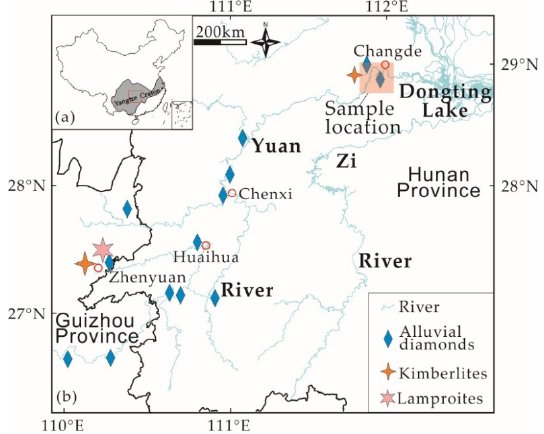
Figure 1. ( a ) Location map for the Yangtze Craton; ( b ) Sketch map of the Yuan River basin and the sample location. Modified by [12].